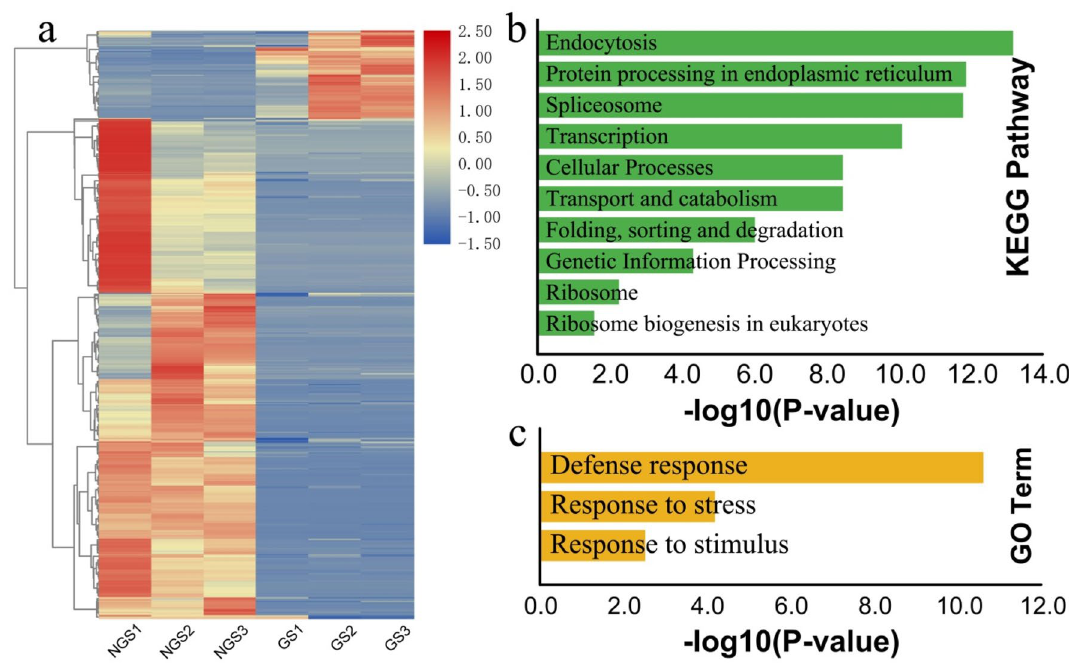
Figure 5. Hierarchical clustering and GO/KEGG enrichment analyses for the target genes of the differentially expressed miRNAs. ( a ) Hierarchical clustering of target genes based on log 2 FPKM values. Red and blue indicate transcripts with increased and decreased levels, respectively. NGS non-germinated seeds, GS germinated seeds. ( b ) KEGG pathway enrichment analysis and ( c ) GO enrichment analysis.